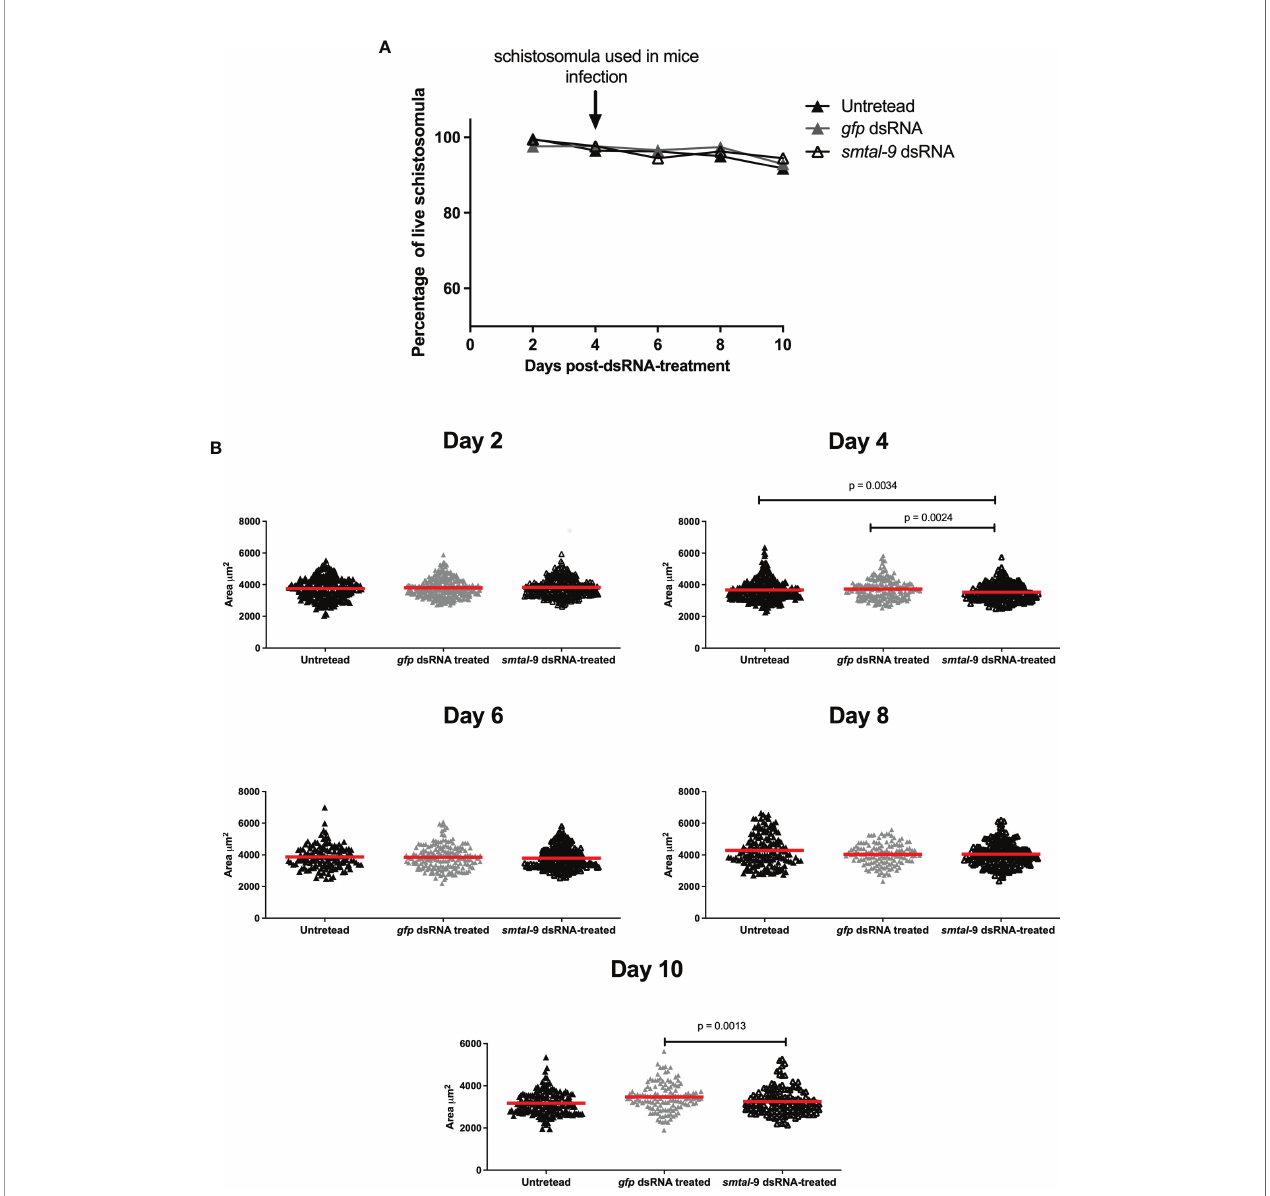
FIGURE 2 | In vitro impact of smtal – 9 knockdown on parasite survival and size. Schistosomula were treated with either smtal – 9 – dsRNA (open triangle), gfp – dsRNA (grey triangle) or untreated (closed triangle). (A) Parasite viability was evaluated every two days after exposure to dsRNA until day 10 post – exposure. The percentage of live parasites was calculated from three independent replicate experiments and differences between groups were determined using one – way ANOVA. (B) Parasite size was calculated for parasites recovered from the cultures of each group every two days until the 10 th day post – dsRNA – exposure. The size of each parasite is represented in the graphs, with the red line representing the mean parasite area in each group. Signi fi cant differences between groups are indicated on the graphs and were determined using the Mann – Whitney U test using an adjusted a